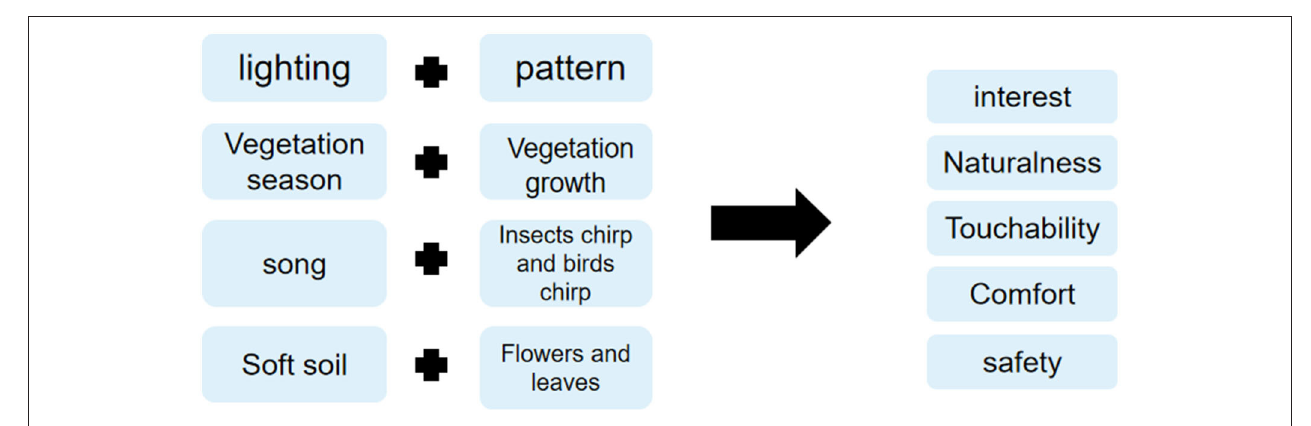
FIGURE 5 | Characteristic diagram of SD